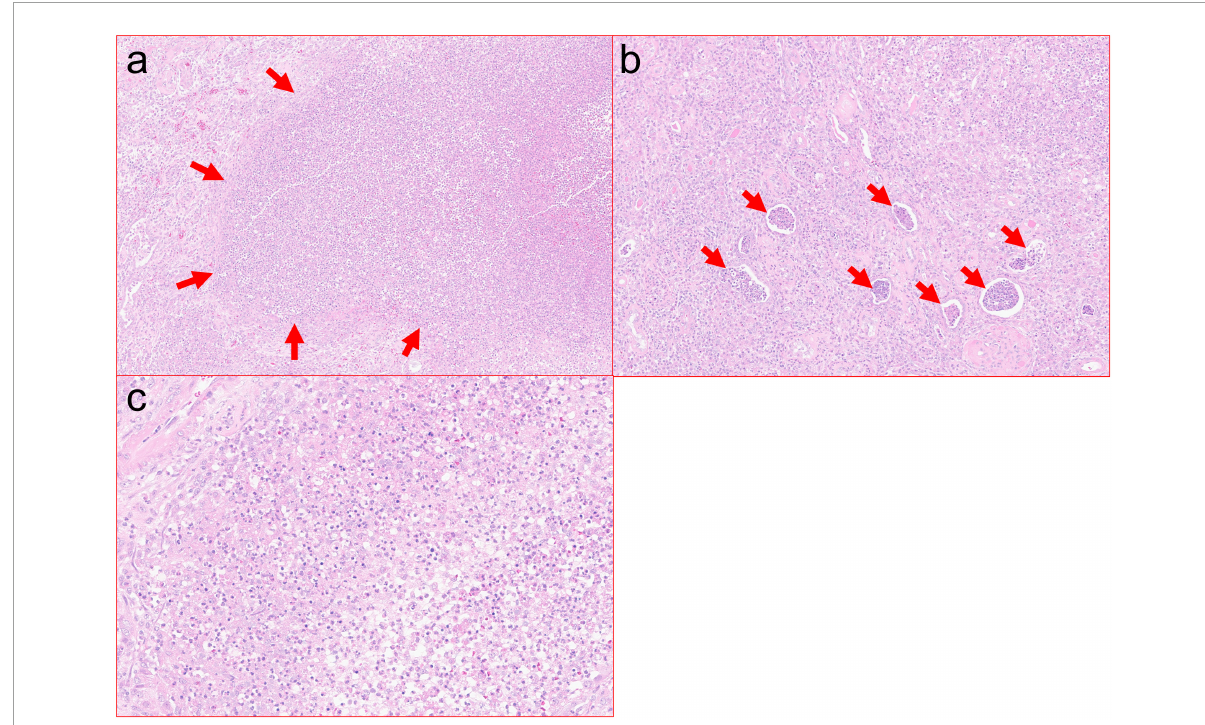
FIGURE4 (a) Cortical abscess with marked neutrophilic inflammation and associated tissue destruction. Zones of tissue necrosis with abscess, such as pictured here, were present extensively throughout the resection specimen (H&E, 10 × ). (b) Severe interstitial neutrophilic inflammation with associated abundant intratubular abscesses (H&E, 20 × ). (c) High power view of neutrophilic inflammation with associated cellular debris (H&E, 40 ×